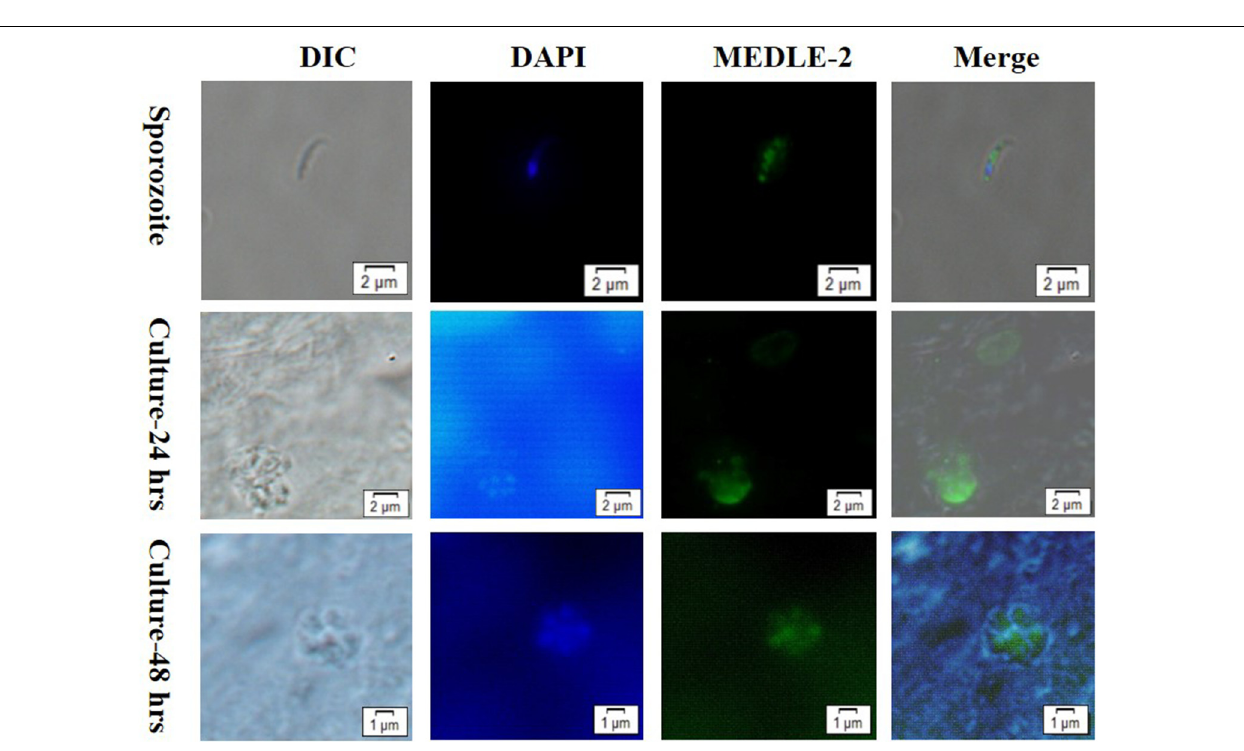
FIGURE 3 | Localization of MEDLE-2 protein expression on Cryptosporidium parvum sporozoites (Top) and developmental stages of C. parvum in HCT-8 cell cultures at 24 and 48 h ( Middle , Bottom , respectively). Images were taken by differential interference contrast microscopy (DIC), fluorescence microscopy using nuclear stain 4, 6-diamidino-2-phenylindole (DAPI), fluorescence microscopy using polyclonal MEDLE-2 antibodies (MEDLE-2), and superimposition of the three